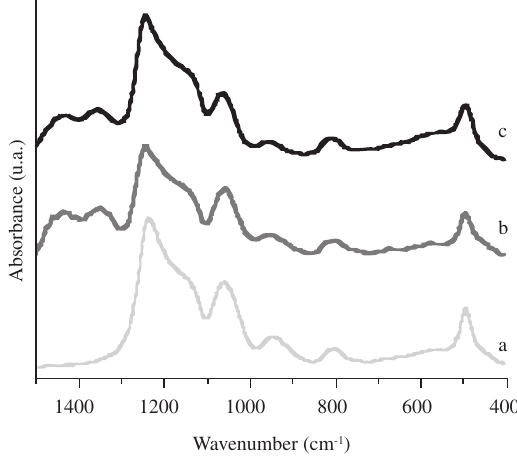
Figure 1. FTIR spectra of a) unary film; b) binary film; c) ternary film at 200 °C for 15 minutes at 75° of incidence.